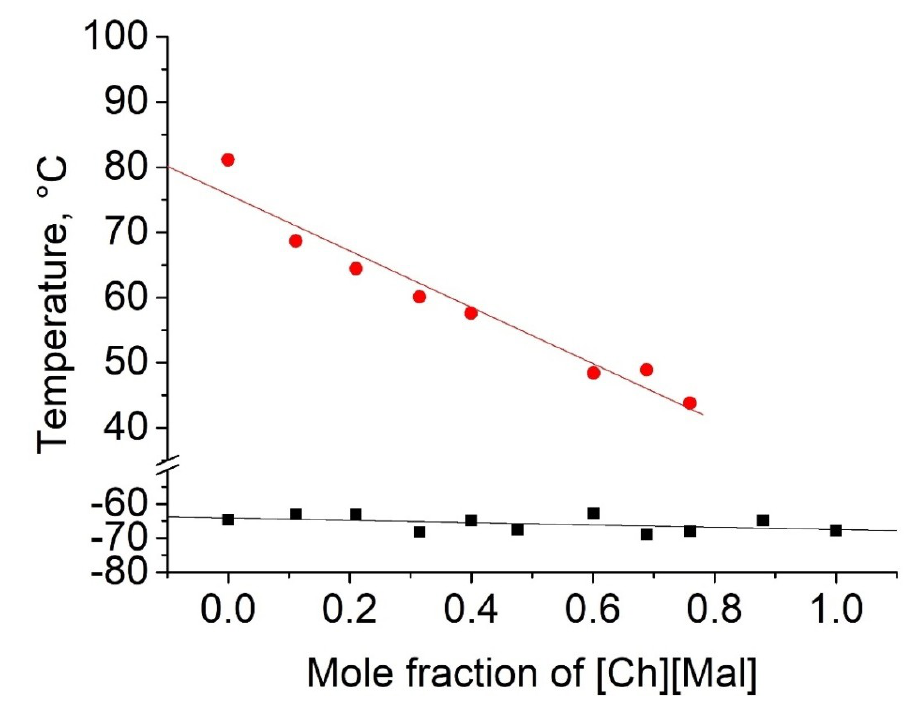
Figure 6. Temperature-composition phase diagram for the mixture of [Ch][Ac] and choline malonate ([Ch][Mal]). Legend: ●—melting points of mixture and [Ch][Ac] component at 1.0 mole fraction;